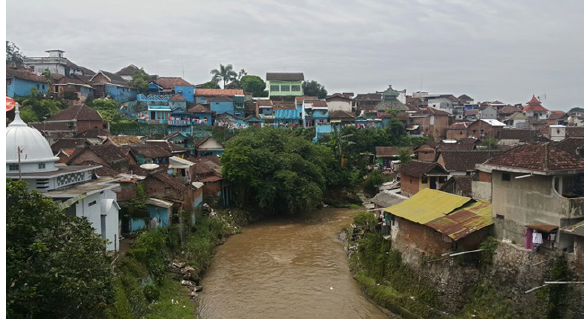
Figure 2. The Malang Kotalama settlement (source: filed survey,